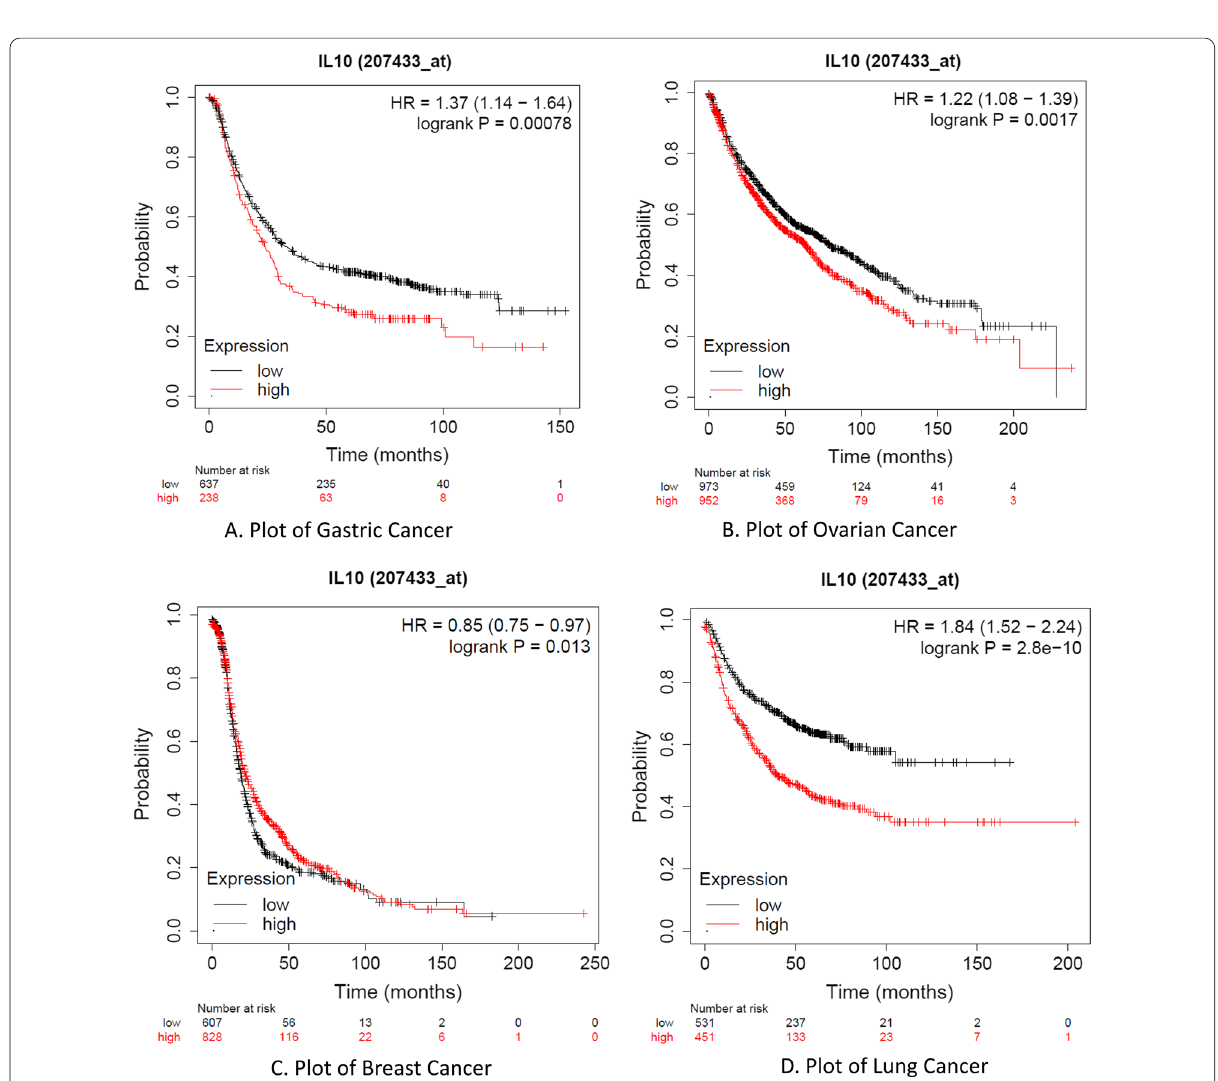
Fig. 6 IL-10 expression data-based (microarray) association study in the survival rate of patients with different types of cancers. This analysis was performed by Kaplan–Meirer